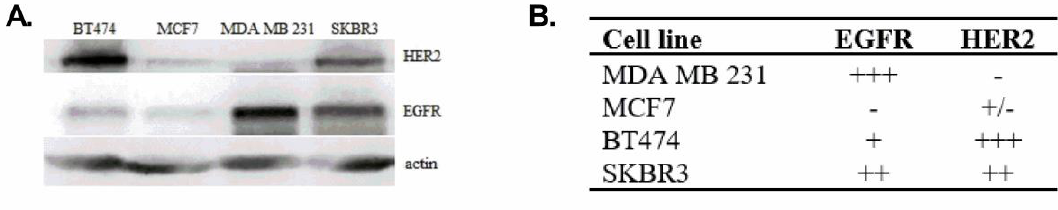
Figure 4. Level of HER2 (ErbB2) and EGFR (ErbB1/HER1) in different breast cancer cell lines used in the study. Expression levels of both receptors in cell lysates prepared from 2.5 × 10 5 cells were determined by Western blot analysis ( A ). Graphical presentation of the levels of HER2 and EGFR in breast cancer cell lines ( B ) was prepared on the basis of ( A ). +: high; −: low. To examine in vitro effectiveness of designed simvastatin liposomes, all four breast cancer cell lines were treated with both liposome formulations and with the free form of the drug at the same concentration range (0.25 µM – 200 µM) for 48 h. The viability of cells was assessed by MTT assay. Among selected breast cancer cell lines, the highest response to free simvastatin was observed for cell lines that overexpress EGFR, MDA MB 231 and SKBR3 (Table 4). The highest sensitivity to treatment with simvastatin liposomes was obtained for the SKBR3 breast cancer cell line (the lowest IC50 value, see Table 4). A significant decrease of IC 50 value after liposomal simvastatin treatment (in comparison to IC 50 for the free drug) was also observed for another cell line overexpressing HER2, BT474. Therefore, we decided to attach an antibody to liposomes that would specifically recognize HER2. In this case, we chose an antibody that is commercially available and commonly used in anti-cancer therapies, trastuzumab (Herceptin). The efficacy of simvastatin immunoliposomes was tested on cell lines overexpressing HER2 and, as a control, on cells that do not express the receptor. It turned out that for both breast cancer cell lines overexpressing HER2, the IC 50 value of simvastatin immunoliposomes was lower than that for the free drug and/or non-targeted liposomes (Table 4). Table 4. IC 50 values for inhibition of cellular viability in breast cancer cell lines after 48 h treatment with free simvastatin and its liposomal and immunoliposomal form. Caption